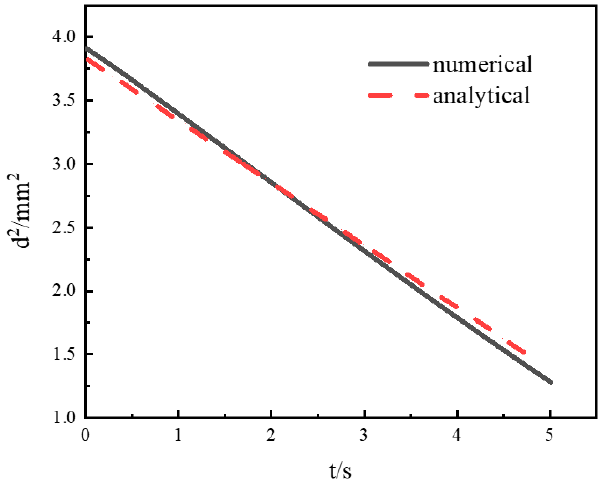
Figure 9. Comparison between numerical and analytical results in terms of d2 value.